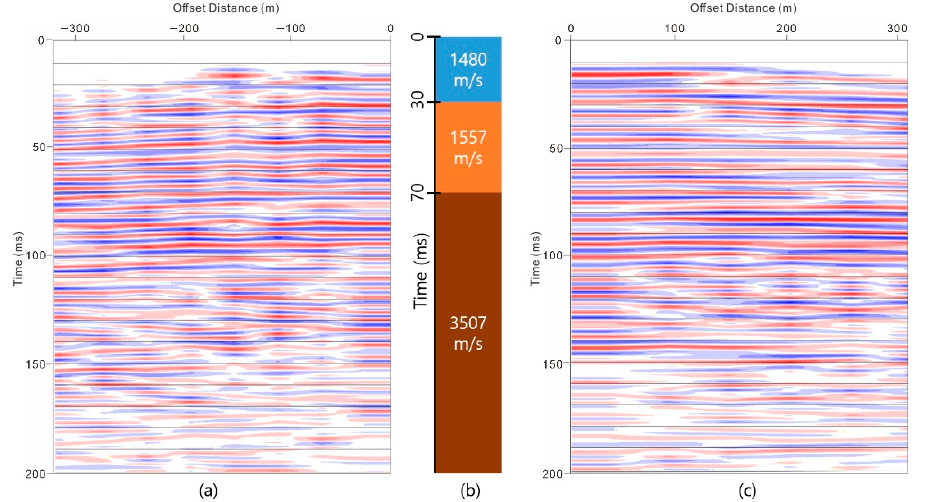
Figure 8. Seismic traces from the wave glider with ( a ) negative offset, ( b ) calculated velocities via travel time, and ( c ) positive offset.